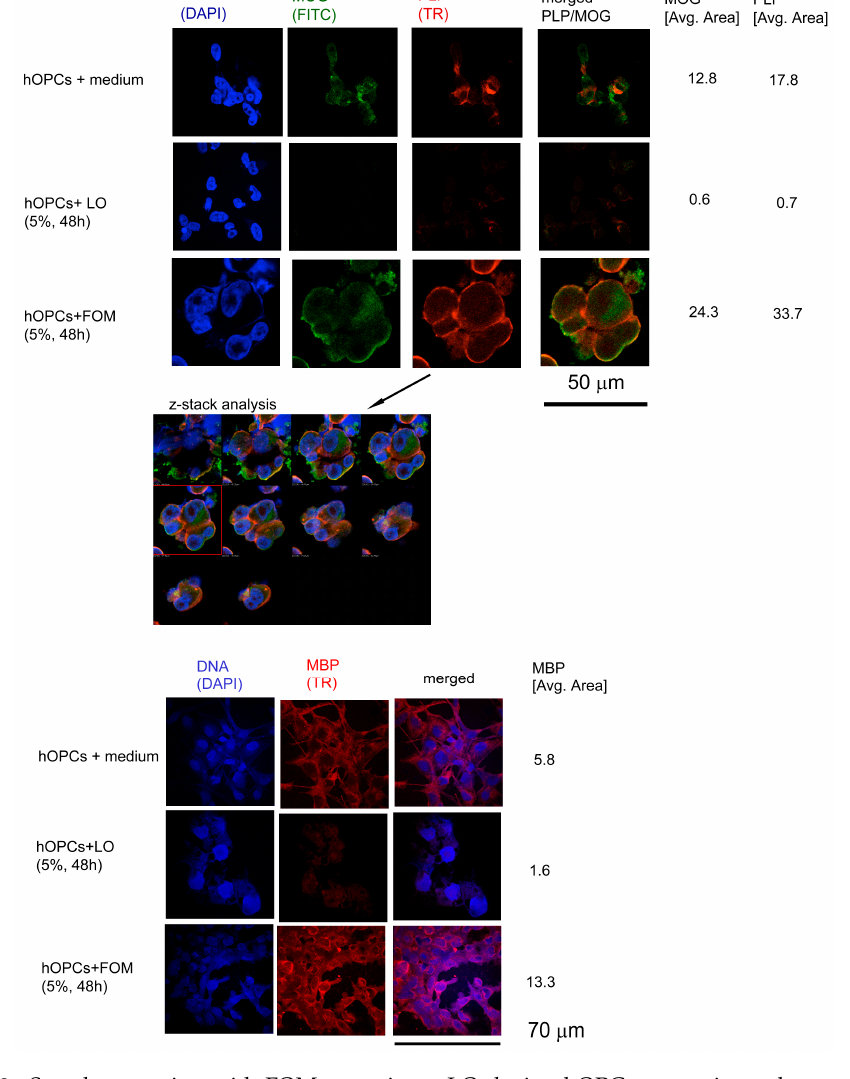
Figure 2. Supplementation with FOM opposite to LO during hOPC maturation enhances myelin oligodendrocyte glycoprotein (MOG), proteolipid protein (PLP), and myelin basic protein (MBP) synthesis by mature oligodendrocytes (OLs). Immunocytochemical (ICC) characterization of hOPCs supplemented with FOM during their di ff erentiation into mature MBP / PLP / MOG-producing OLs. Confocal z-stack analysis confirmed that hOPCs supplemented with FOM were characterized by MOG / PLP accumulation in the intracellular space during their maturation. The data from the quantitative fluorescence signal of protein analysis are presented as average area (Avg Area) from four independent